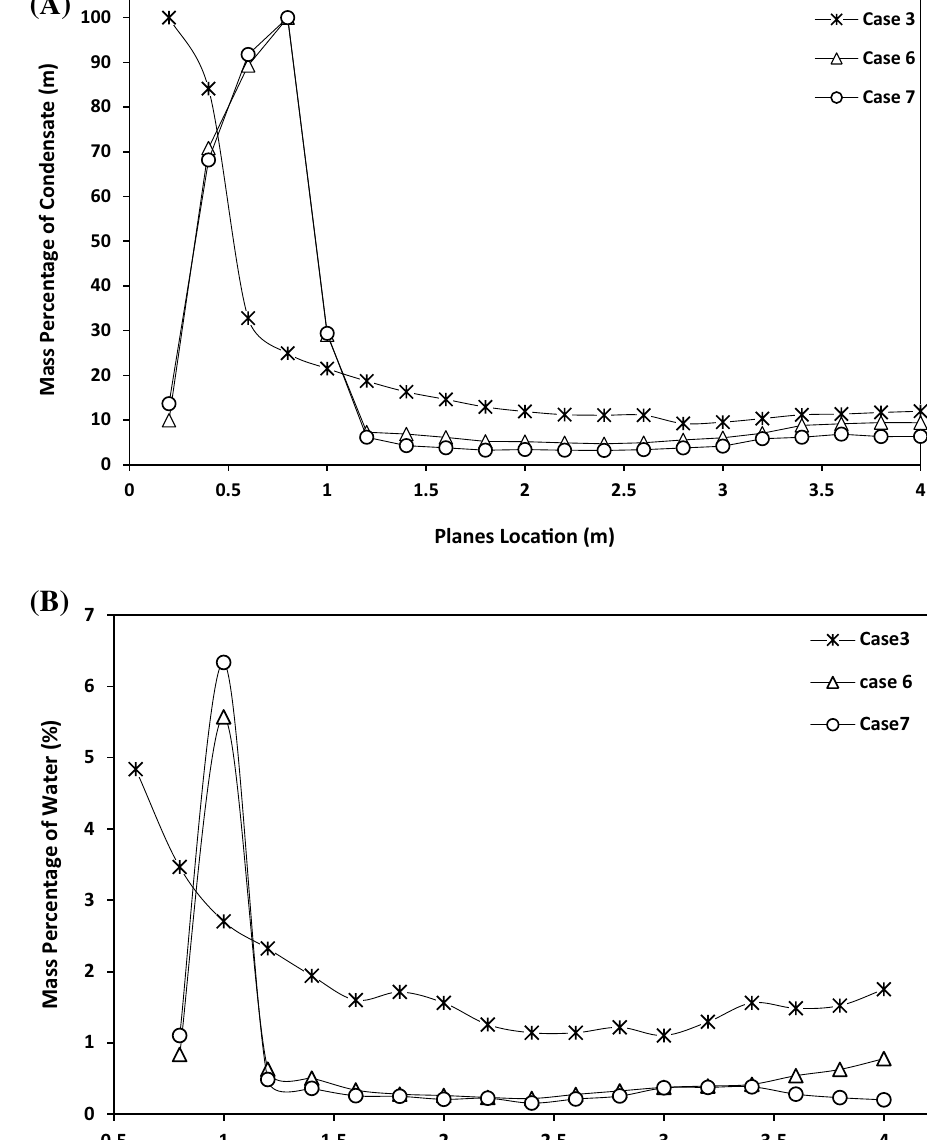
Fig. 21 Simulated mass distri- bution of condensate ( a ) and water ( b ) droplets in the gas zone of Cases 3, 6 and